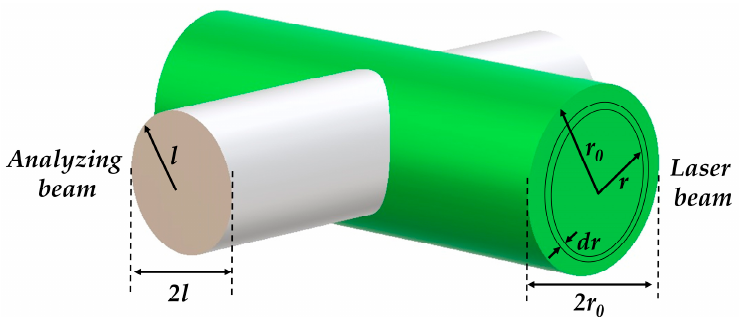
Figure 2. Scheme of propagation of the exciting and analyzing beams, used for calculation of ϕ T value from spectroscopic data.